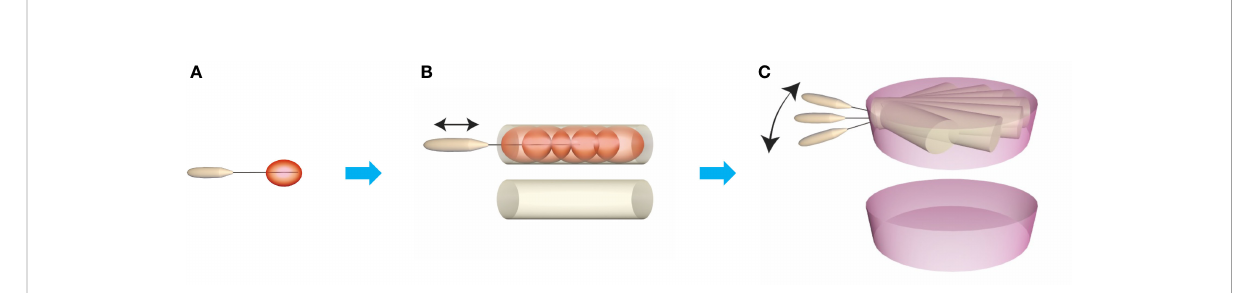
FIGURE 2 Construction of ablation plane unit. The basic ablation unit is generated keeping electrodes stable for 3-5 (A) and the ablation cylindrical unit is generated by moving the electrode on the same line from deepest part to super fi cial part (B) . Then, move the electrode on the horizontal axis making the ablation cylindrical units overlapping, and then the ablation plane unit on the horizontal axis is produced (C) .